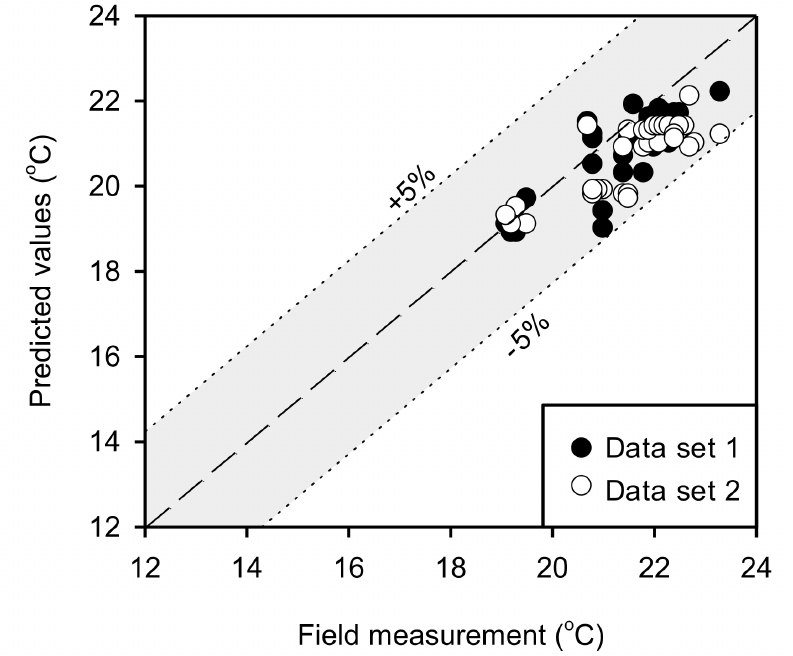
Figure 8. Comparison between FE simulation and measured temperature at the bottom of concrete